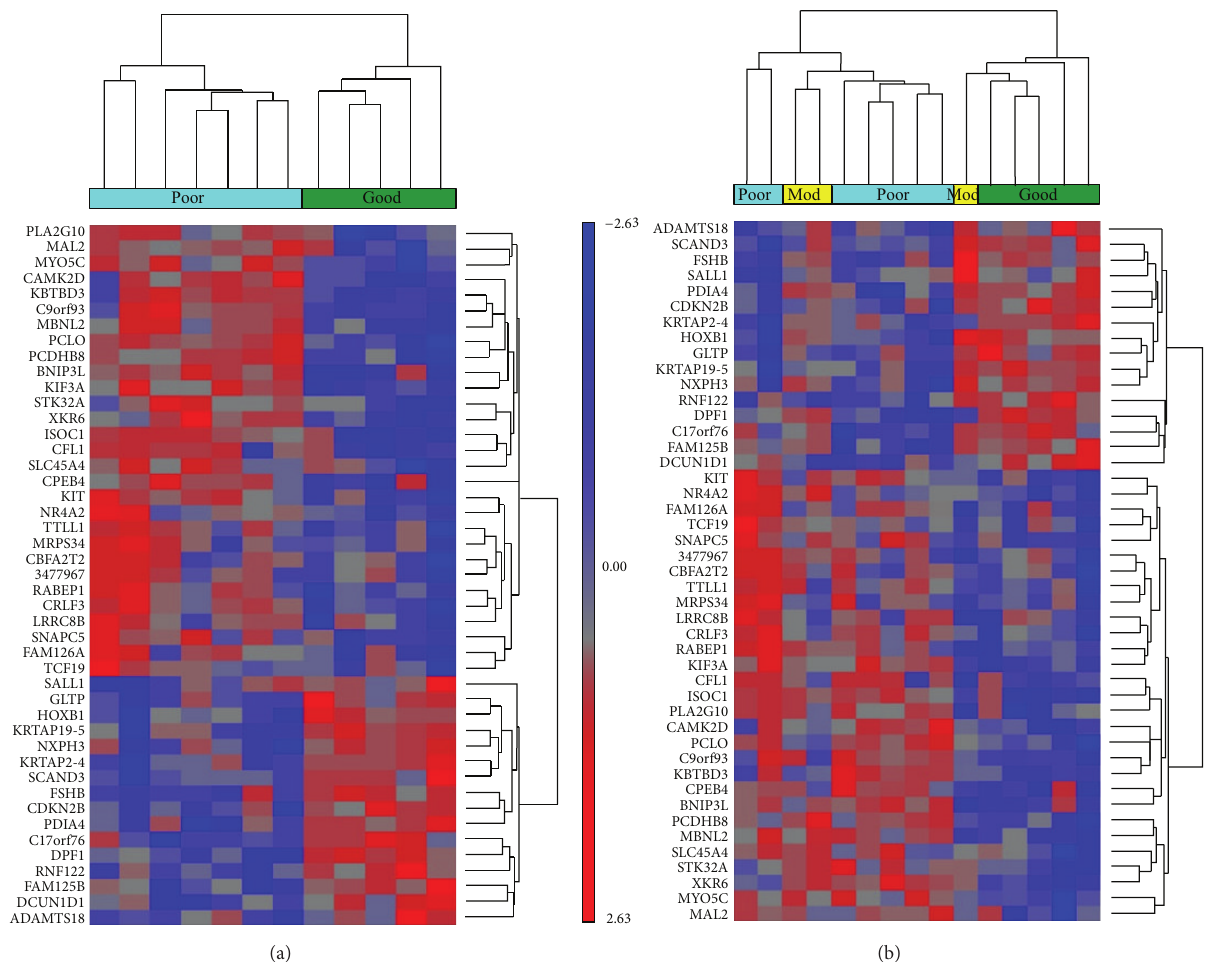
Figure 2: Hierarchical clustering of Merkel cell carcinoma samples. Samples were clustered based upon the expression pattern of 45 differentially expressed genes between tumors of poor and good prognosis patients ( 𝑃 ≤ 0.01 and 1.5-fold cutoff). Individual samples are represented on the 𝑥 -axis with poor prognosis patients in light blue (“poor”), good prognosis in green (“good”), and moderate prognosis in yellow (“mod”). Differentially expressed genes are shown on the 𝑦 -axis. Clustering of (a) good and poor prognosis patients; (b) good, moderate, and poor prognosis patients. The scale of gene expression values are standardized such that genes are shifted to a mean of zero and scaled to a standard deviation of